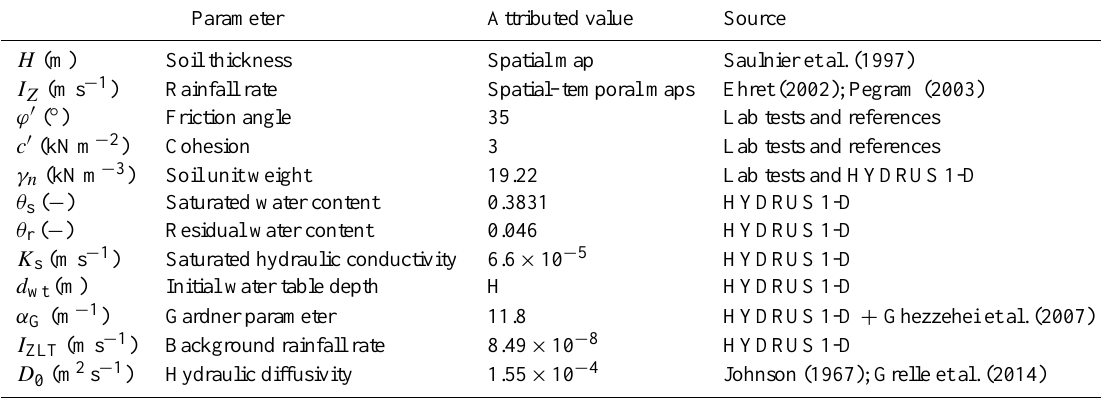
Table 3. Input parameters for the TRIGRS model.